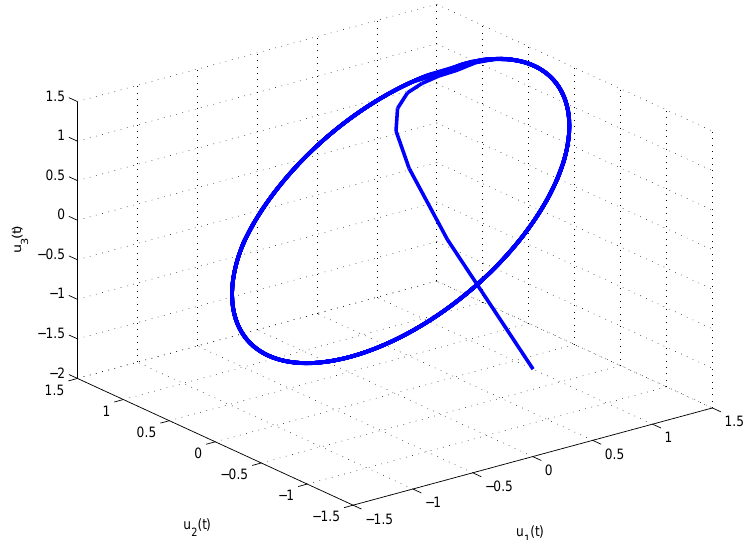
Figure 3. The phase trajectories of u 1 ( t ) , u 2 ( t ) and u 3 ( t ) of system (70) for the external inputs x ( t ) = [ 1 + sin t ,1 + cos t ,1 + sin t ] T in Example